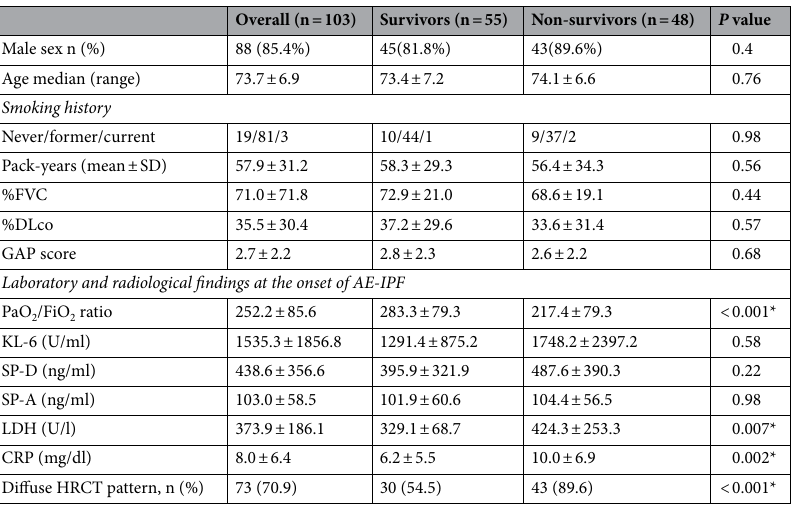
Table 1. Characteristics of 103 patients with AE-IPF. %FVC, Forced vital capacity, % of predicted value; %DLco, Carbon monoxide diffusing capacity -% of predicted value; GAP score. Gender-Age-Physiology score; KL-6, Krebs von der Lungen-6; SP-D, surfactant protein D; SP-A, surfactant protein A; LDH, lactate dehydrogenase; CRP, C-reactive protein; HRCT, high-resolution computed tomography; CS, corticosteroid, PMX-DHP, Polymyxin B-immobilized fiber column-direct hemoperfusion; rhTM, recombinant human thrombomodulin. * P <